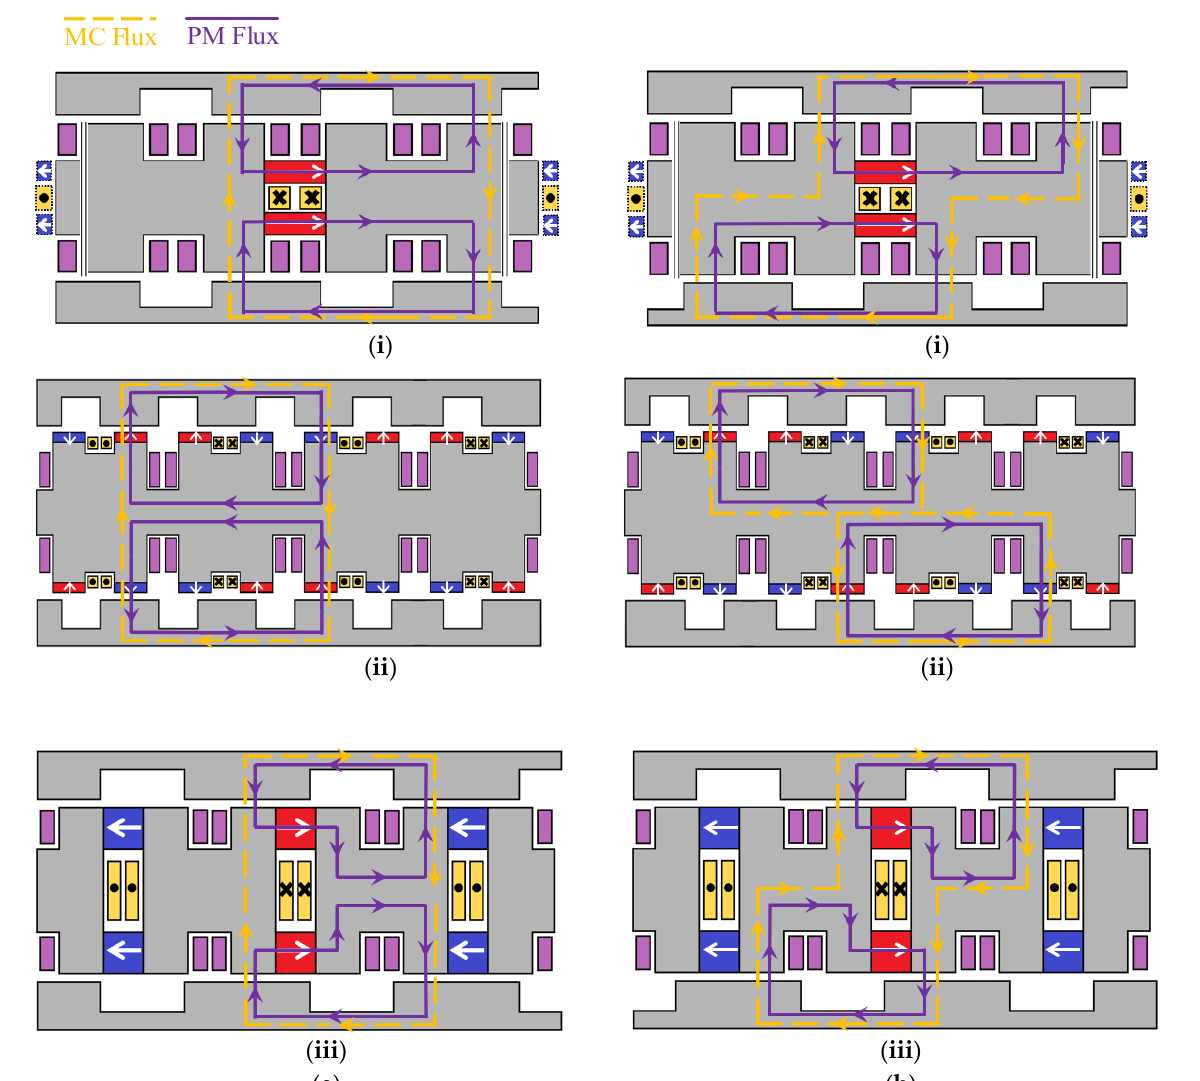
Figure 2. Operation principles of three AF-DR motors with rotors. ( a ) Aligned position: ( i ) DSPM, ( ii ) FRPM, ( iii ) FSPM. ( b ) Unaligned position: ( i ) DSPM, ( ii ) FRPM, ( iii ) FSPM.